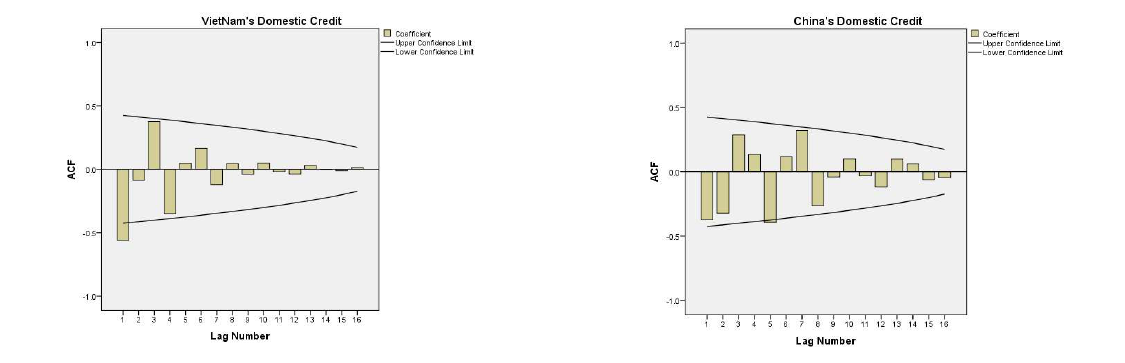
Fig. 6. China’s Series Autocorrelation Plots (The Box - Jenkins Method, (q=5))